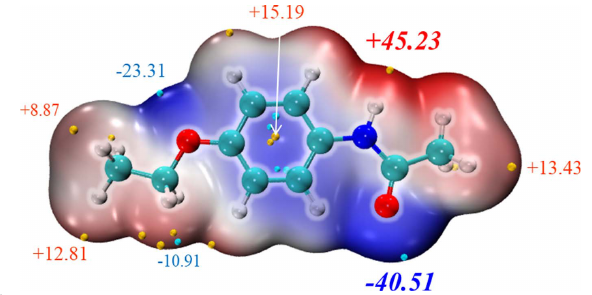
Figure 11 van der Waals surface electrostatic potential of PHEN plotted using Multiwfn and VMD .